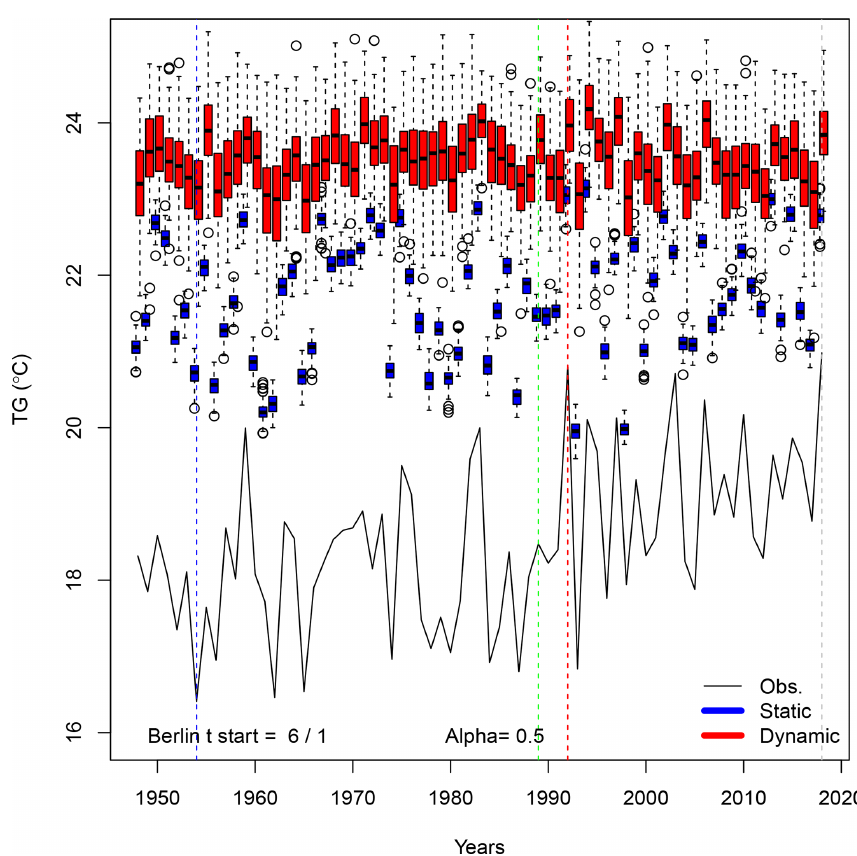
Figure A1. Time variations of probability distributions of simulated average temperatures (TG) for α TG = 0 . 5 in Berlin. The black continuous line represents the observed variations in Berlin summer averages between 1948 and 2018. Temperatures are expressed in degrees Celsius. The vertical colored lines outline the coldest (blue), median (green), warmest (red) and 2018 summers. The box plots represent the ensemble variability of the simulations for each year. The red box plots are for the dynamic simulations. The blue box plots are for the static simulations. The boxes of box plots indicate the median ( q 50 ), lower ( q 25 ) and upper ( q 75 ) quartiles. The upper whiskers indicate min [ max (T ), 1 . 5 × (q 75 − q 25 ) ] . The lower whisker has a symmetric formulation. The points are the simulated values that are above or below the defined